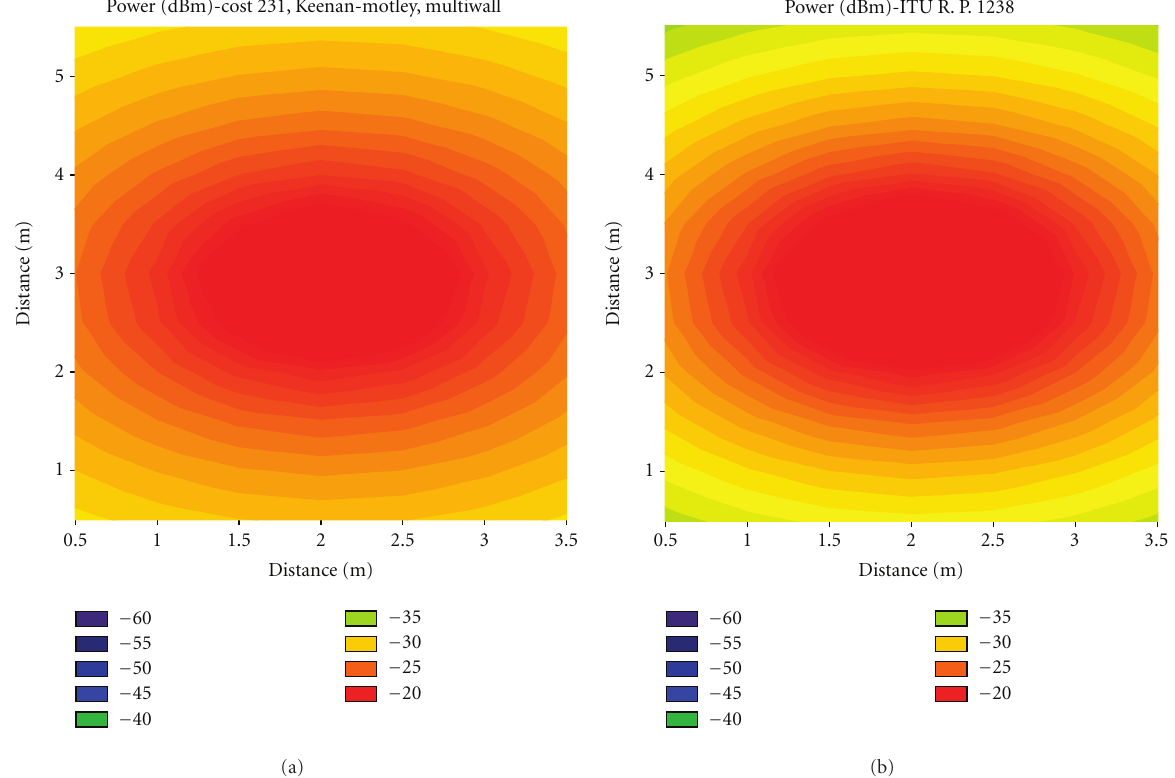
Figure 3: (a) Spatial distribution of received power (dBm) for a height of 1.05 m in the indoor scenario of Figure 2(a) with Cost 231, Keenan- motley, and multiwall models. (b) Spatial distribution of received power (dBm) for a height of 1.05 m in the indoor scenario of Figure 2(a) with ITU R. P. 1238